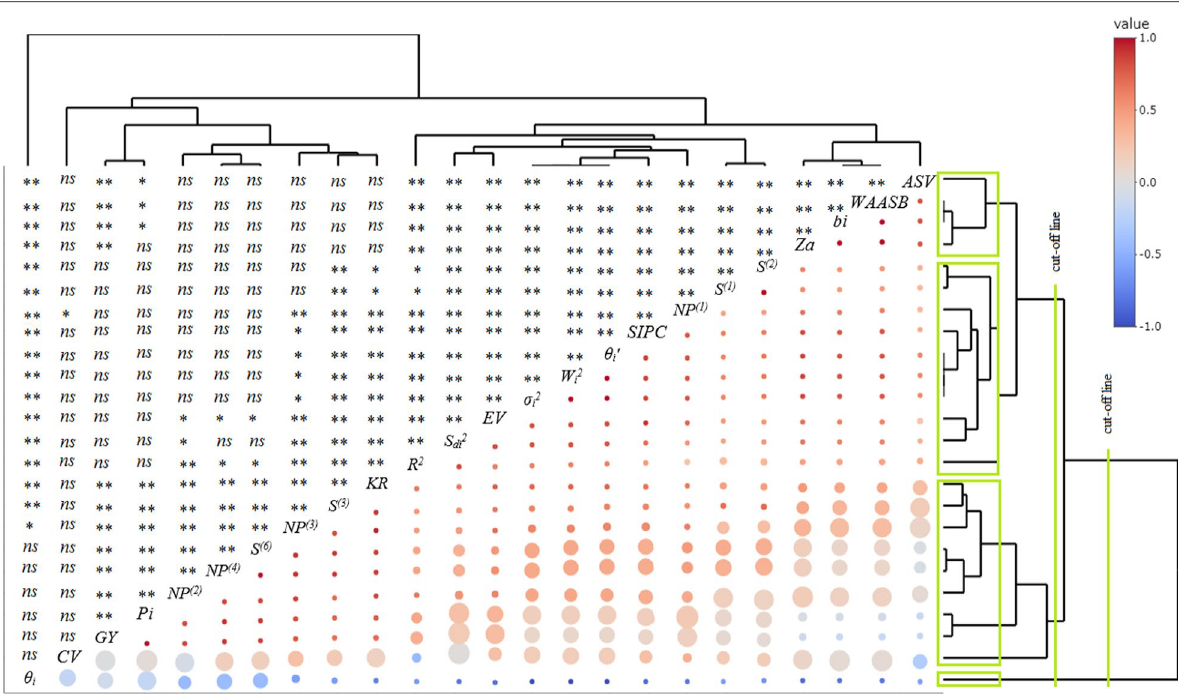
Fig. 3 Heatmap showing the relationships between grain yield and stability statistics based on Spearman’s rank correlation test. GY grain yield, S (i) Huehn’s (1979) and Nassar and Huehn’s (1987) nonparametric stability statistics, NP (i) Thennarasu’s (1995) nonparametric stability statistics, LR Kang’s (1988) rank‑sum, W i2 Wricke’s (1962) ecovalance, σ i2 Shukla’s (1972) stability variance, S di2 deviation from regression, bi slope of regression line, θ i Plaisted and Peterson’s (1959) mean variance component, θ i ’ Plaisted’s (1960) GE variance component, Pi Lin and Binns’s (1988) superiority index, R 2 Pinthus’s (1973) coefficients of determination, ASV AMMI stability value, SIPC sum of the absolute value of the IPCA scores, EV average of the squared eigenvector values, Za the absolute value of the relative contribution of IPCAs to the interaction, WAASB the weighted average of absolute scores. ns, * and ** indicate nonsignificant, and significant at 0.05 and 0.01 probability levels, respectively